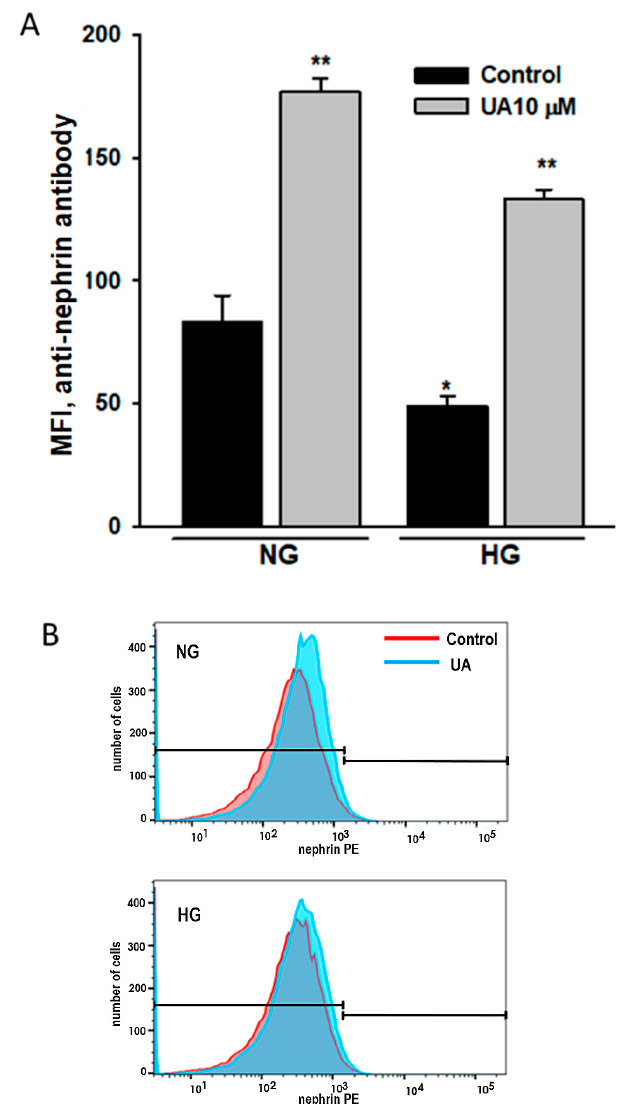
Figure 12. Urolithin A increased nephrin expression at the podocyte surface. Podocytes cultured for 7 d in normal (5.5 mM, NG) or high (25 mM, HG) glucose were incubated for 24 h with 10 µM UA, stained with phycoerythrin-conjugated antibody against the extracellular nephrin domain and analyzed by flow cytometry. Quantitative analysis of UA and UB effects ( A ) and representative his- togram showing the effect of UA ( B ) on extracellular nephrin expression. Results show mean ± SEM. Mann–Whitney test was used to calculate p values. * p < 0.05 vs. NG Control, ** p < 0.001 vs. respective Control ( n = 5). MFI: mean fluorescence